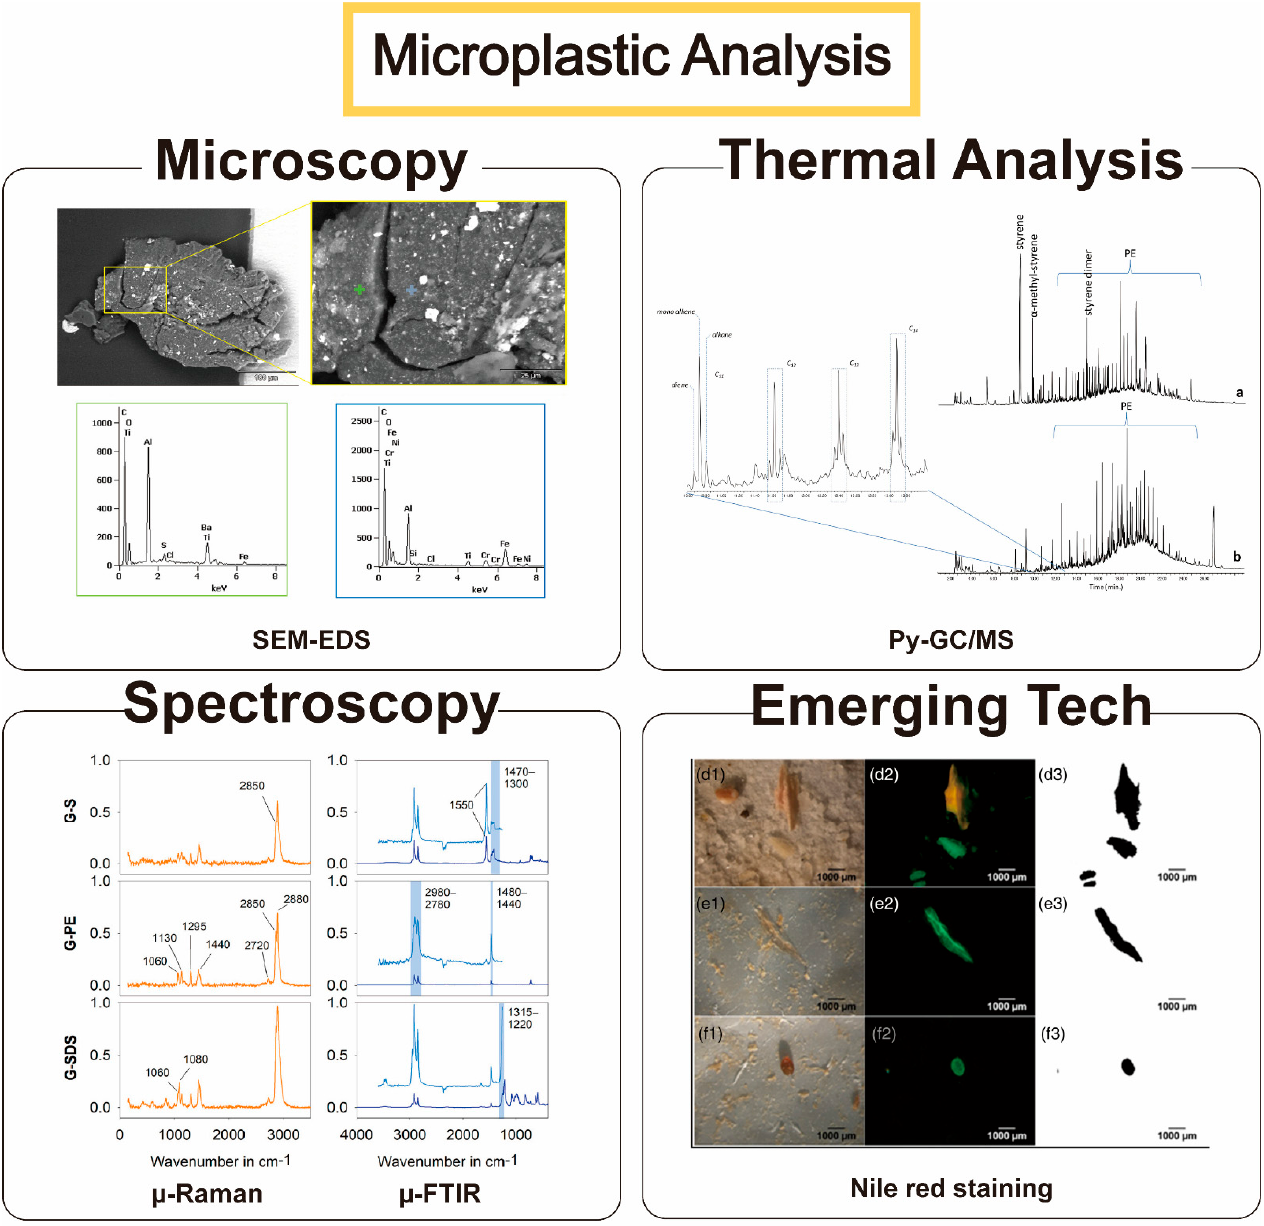
Figure 1. Four major approaches to analyze microplastics in the environment. Microscopic observation allows the size, shape, and chemical composition of target microplastics to be directly probed. Thermal and spectroscopic analyses allow researchers to understand target plastics’ chemical and physical signatures. Emerging technologies, including a simple dye staining method, help to expedite the simultaneous, high-throughput capture of microplastics without using expensive analytical instruments. In Figure, photographs (d1, e1, f1), Nile Red staining (d2, e2, f2) and the analysis process by Image J program can be checked. Reprinted with permission from the reference [32–35] . Copyright 2018, 2019, 2020 American Chemical Society. Additionally, copyright 2019 John Wiley and Sons.